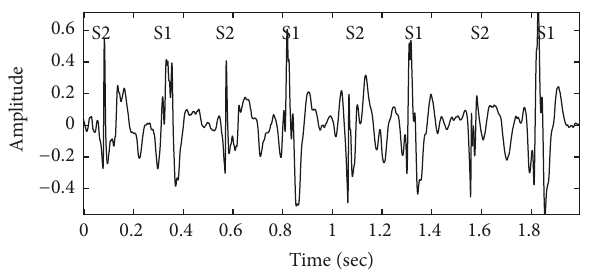
Figure 1: An auscultatory